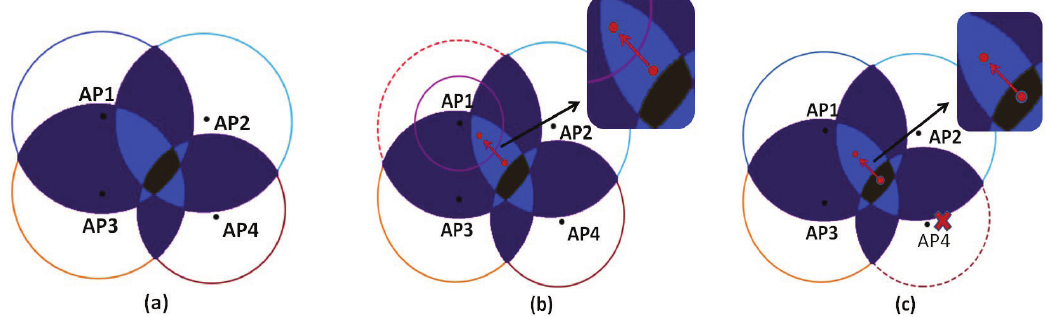
Figure 4. Localization error analysis. ( a ) Description of the normal position area. ( b ) Description of the position area when an AP is impaired. ( c ) Description of the position area when an AP is